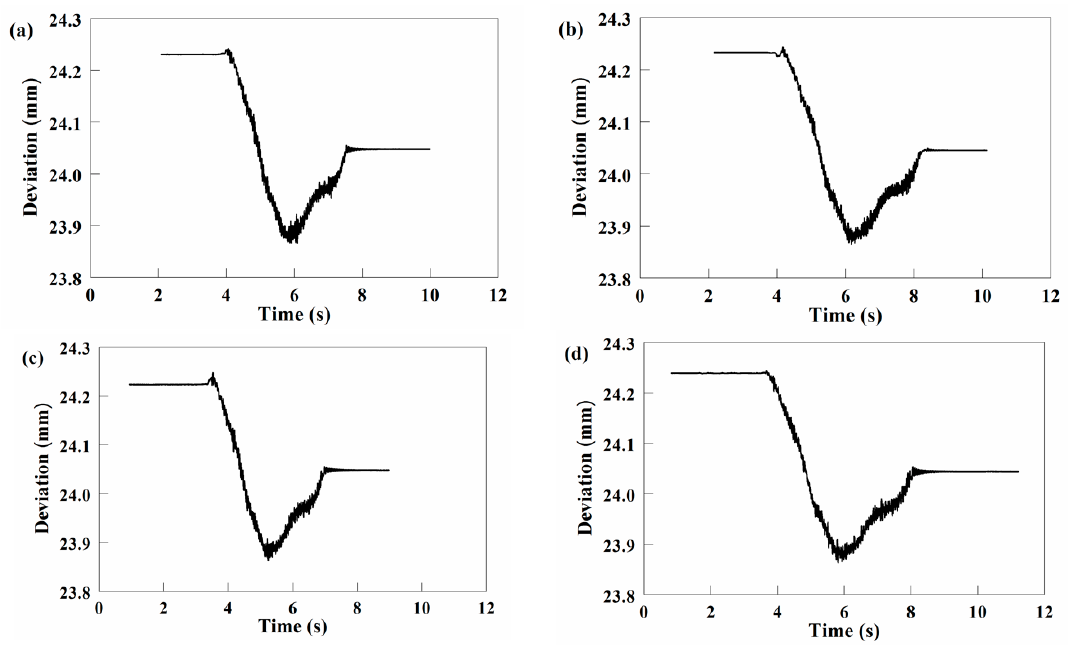
Figure 28. The measurements when PD is the measured surface ( a ) measurements 1 ( b ) measurements 2 ( c ) measurements 3 ( d ) measurements 4.